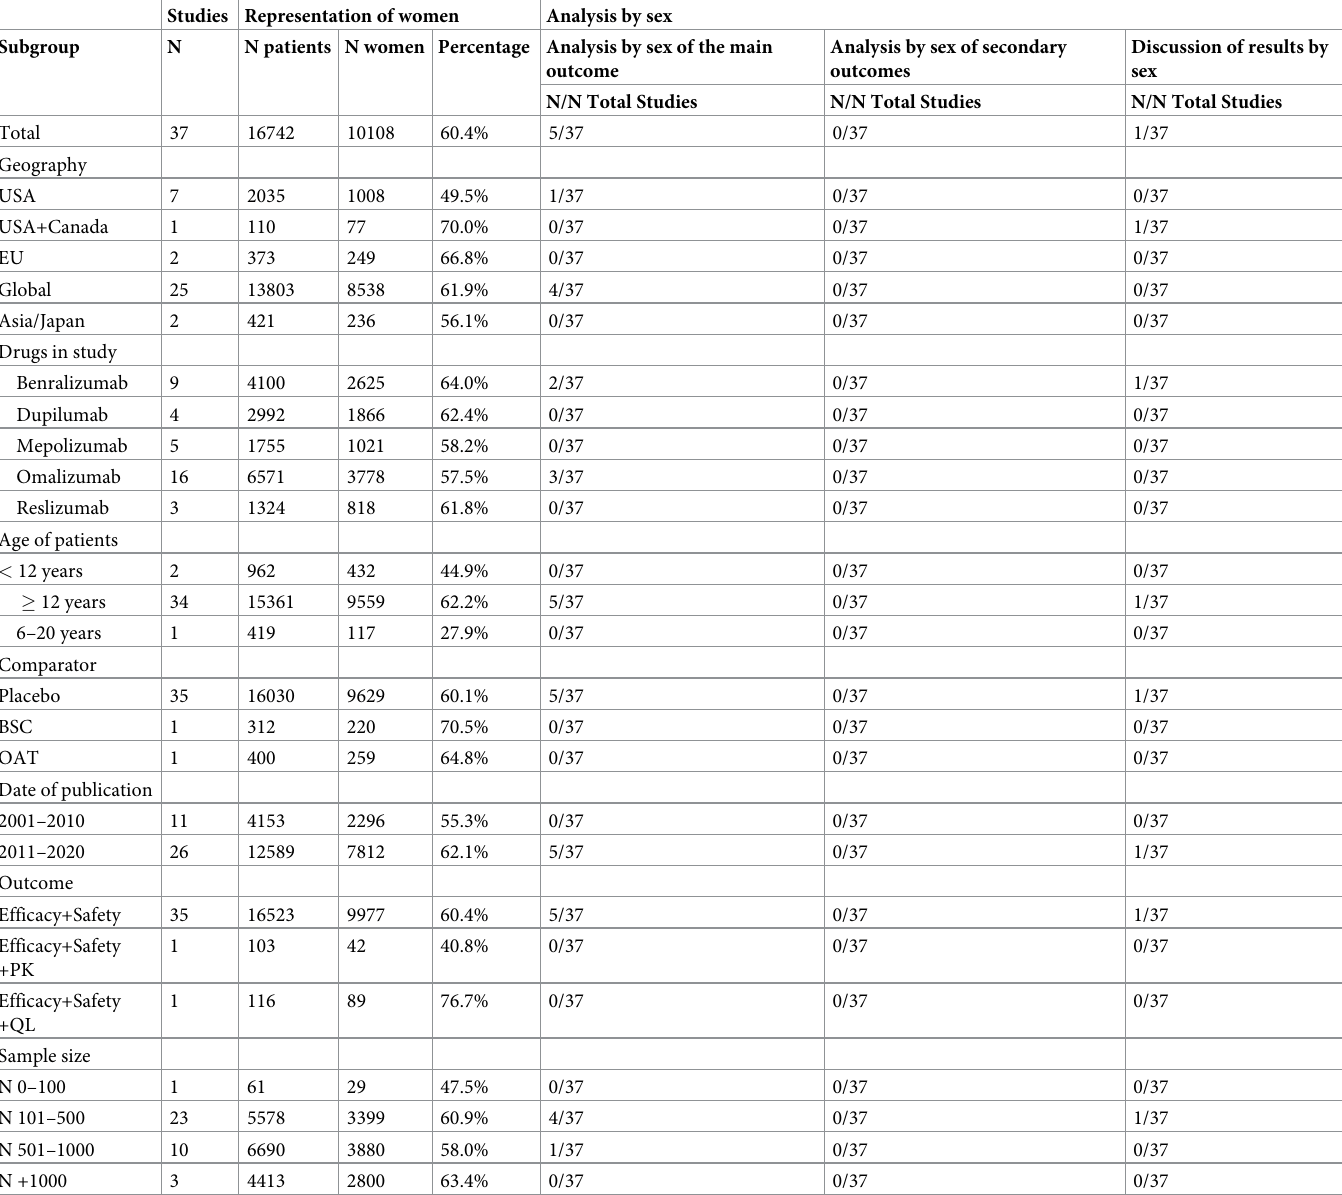
Table 4. Proportion of women and other characteristics of sex assessment according to the different subgroups. Studies Representation of women Analysis by